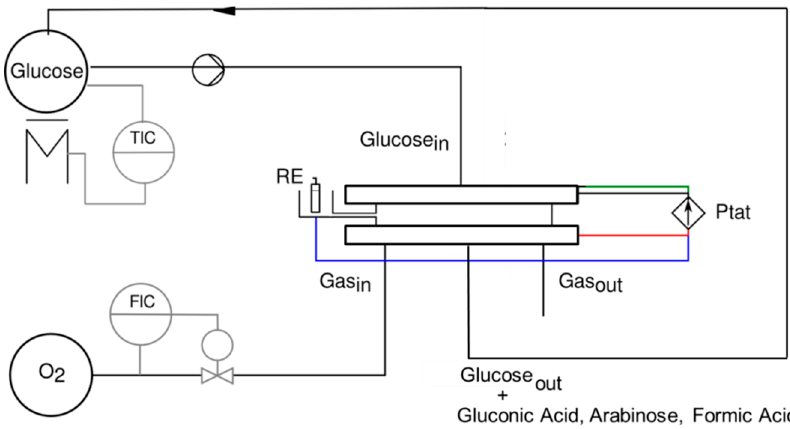
Figure 9. Schematic representation of electrochemical reactor experimental facility.